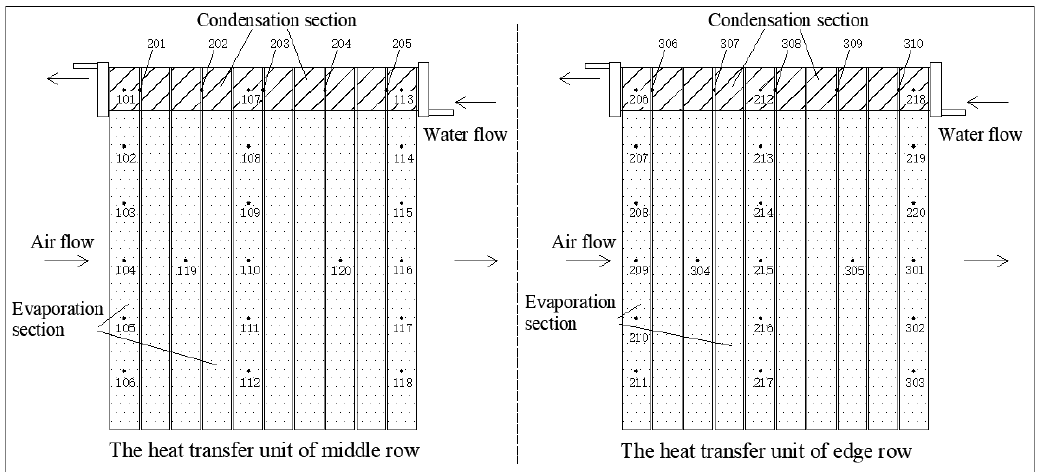
Figure 5. Distribution of the temperature measurement points.